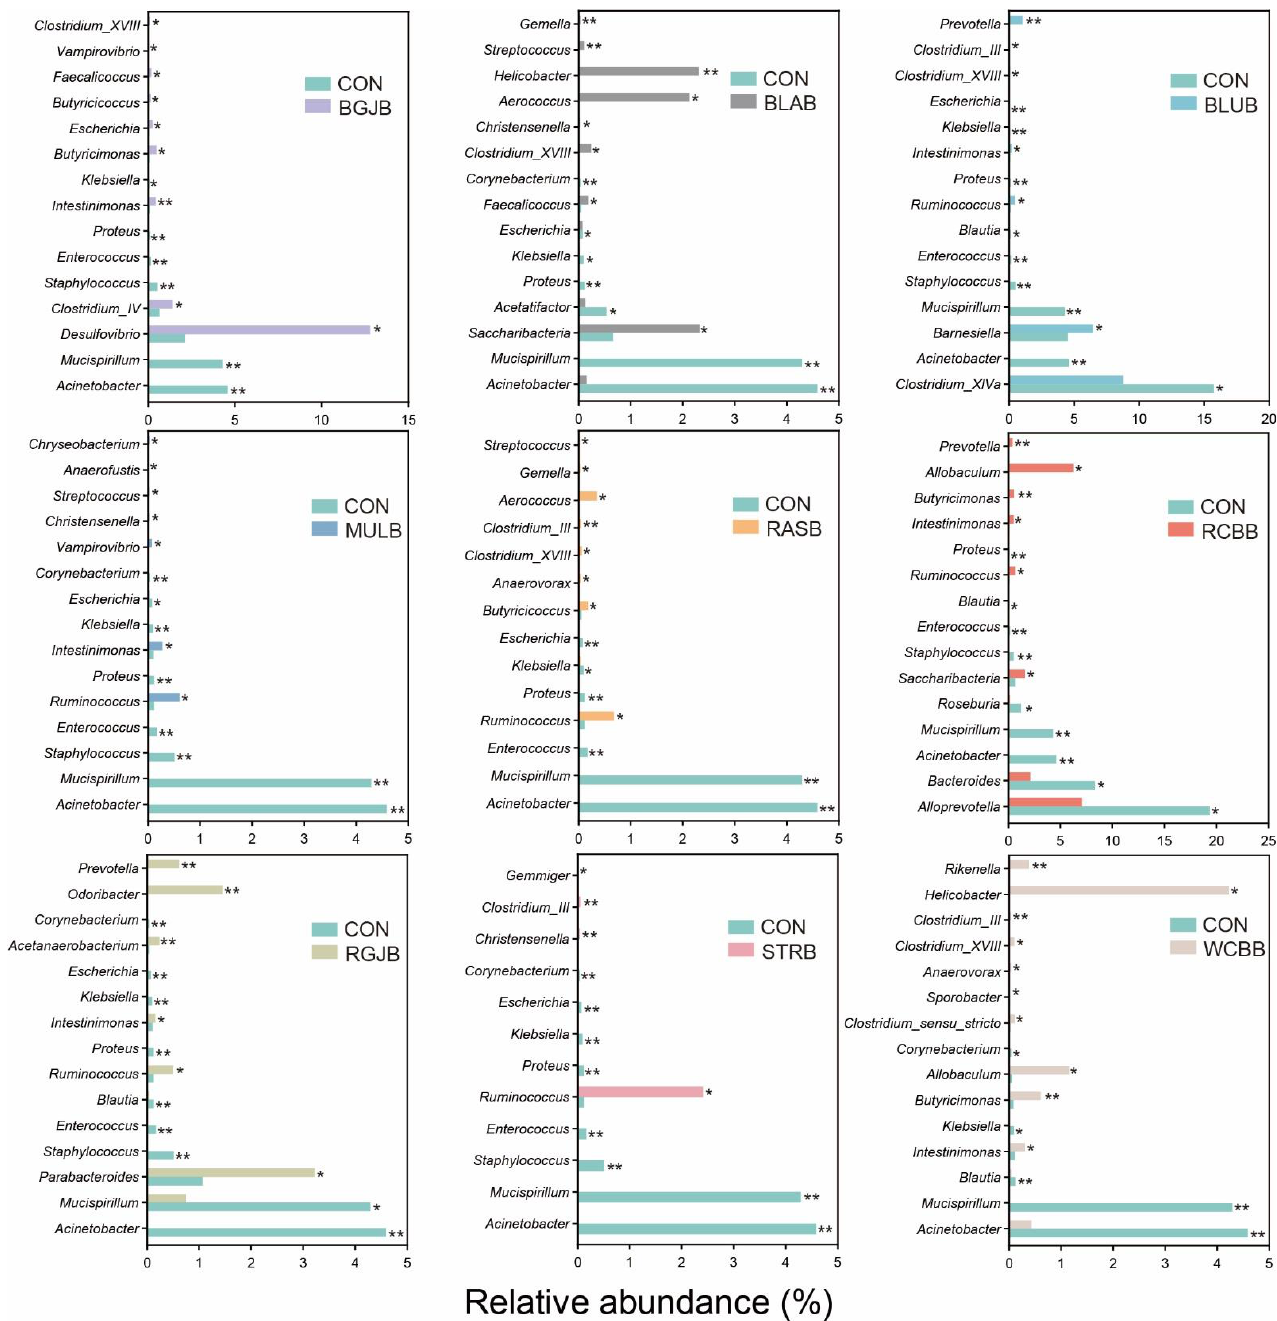
Figure 6. The relative abundance of top 15 genera with significant difference compared with control group in each berry group. Statistical significance was determined by Mann-Whitney U test for two groups comparisons. *, compared with control group. *, p < 0.05; **, p < 0.01. (n = 7/group).